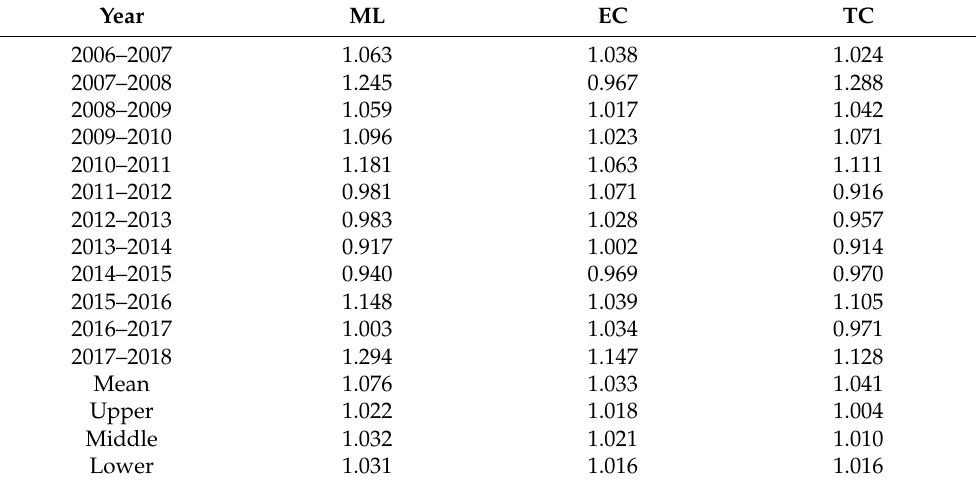
Table 4. ML index and decomposition of energy eco-efficiency in the YRB from 2006–2018. Year ML